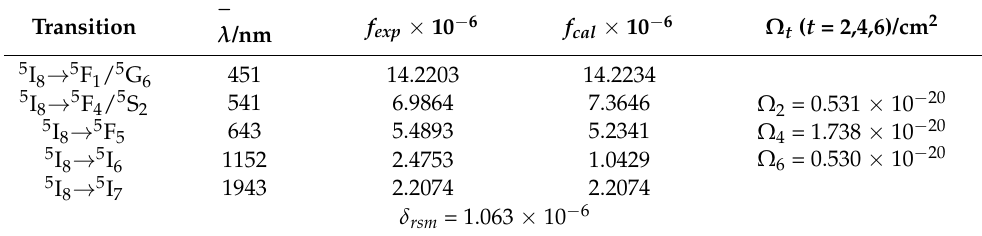
Table 2. f cal , f exp , δ rsm , and Ω t ( t = 2, 4, and 6) of PMN-32PT:Ho 3+ /Yb 3+ crystal.